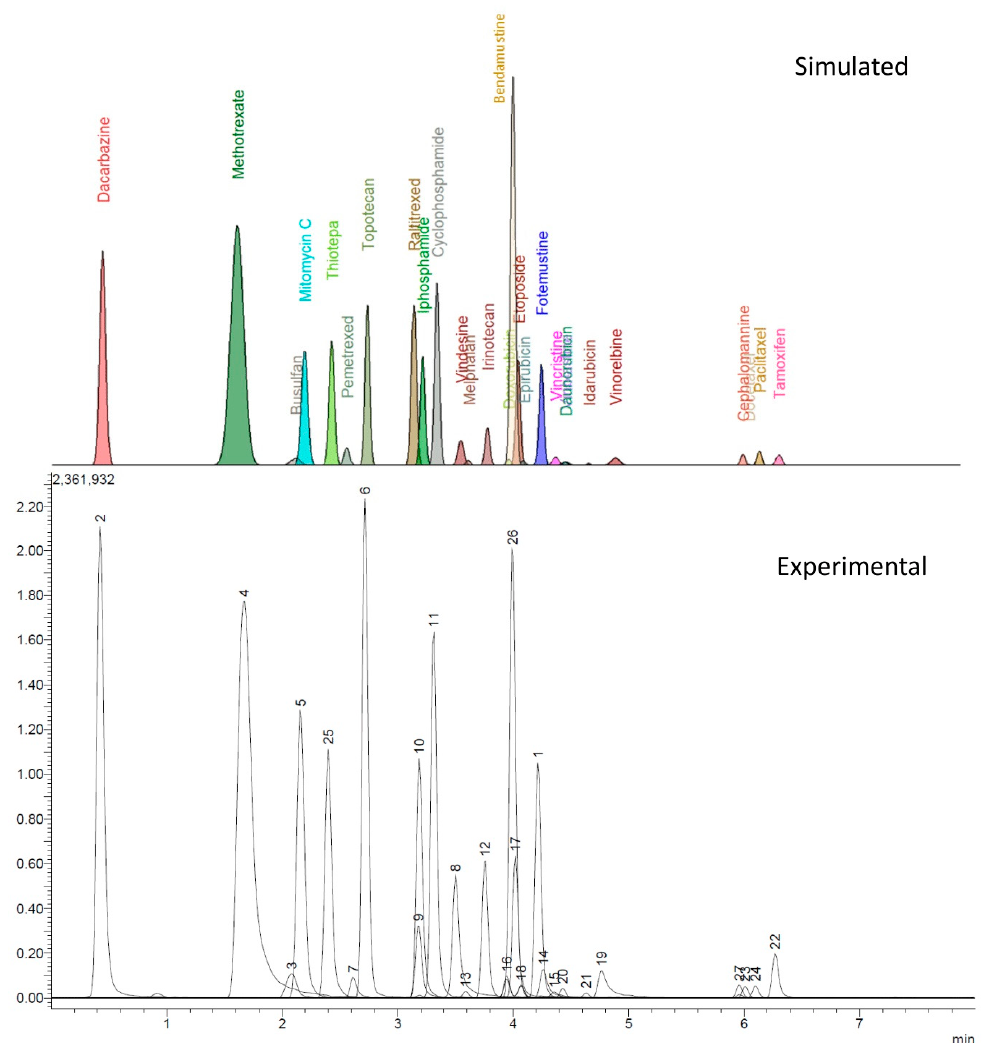
Figure 1. Comparing the accordance between computed and experimental chromatogram. LEGEND: 1, fotemustine; 2, dacarbazine; 3, busulfan; 4, methotrexate; 5, mitomycin C; 6, topotecan; 7, pemetrexed; 8, vindesine; 9, raltitrexed; 10, ifosfamide; 11, cyclophosphamide; 12, irinotecan; 13, melphalan; 14, vincristine; 15, vinblastine; 16, doxorubicin; 17, etoposide; 18, epirubicin; 19, vinorelbine; 20, daunorubicin; 21, idarubicin; 22, tamoxifen; 23, docetaxel; 24, paclitaxel;